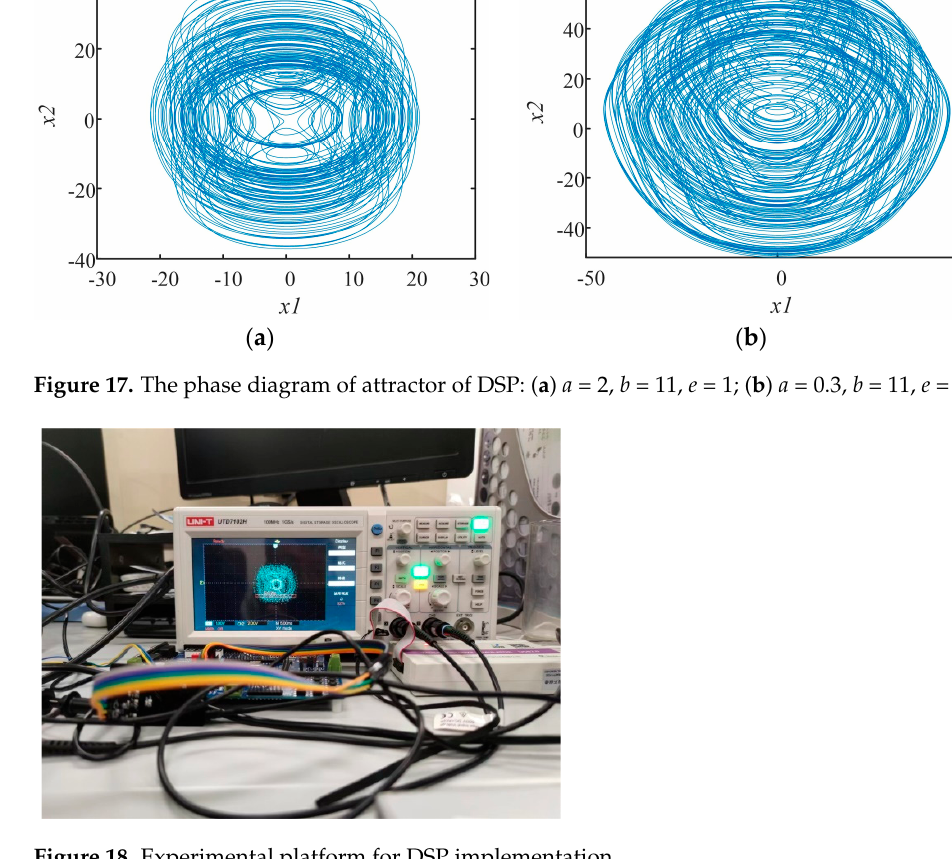
Figure 17. The phase diagram of attractor of DSP: ( a ) a = 2, b = 11, e = 1; ( b ) a = 0.3, b = 11, e = 7.